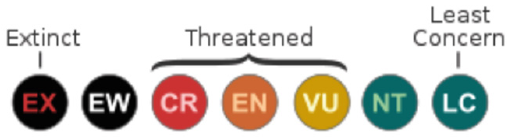
Figure 10. Scheme of conservation status of species according to the IUCN criteria [79]. Species were assessed using five criteria [79] according to species distribution range, population size, and population change, in combination with extinction probability assess- ment. These criteria determined which category was most significant for each